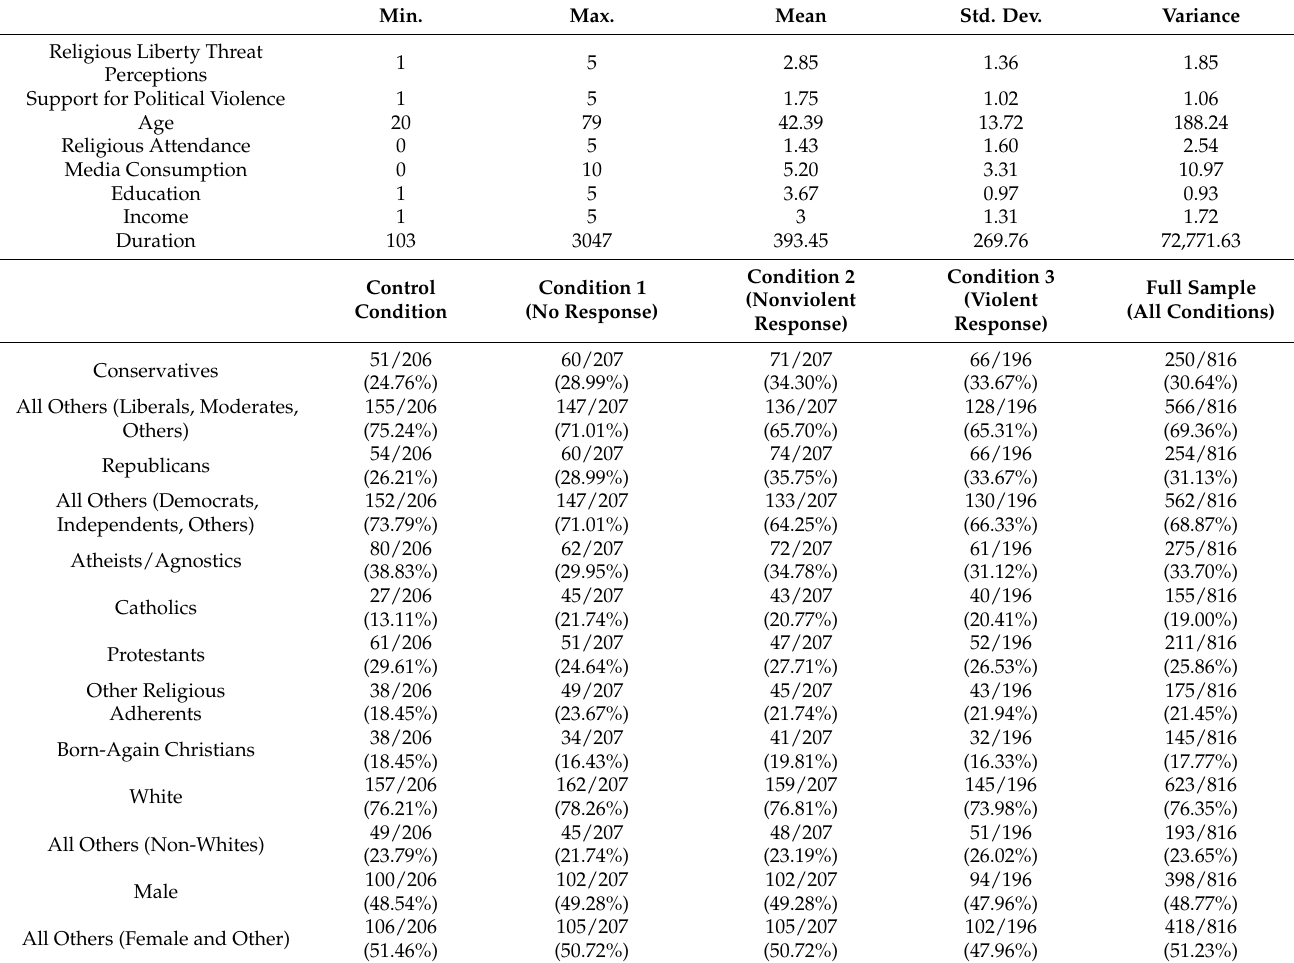
Table 3. Summary statistics and post-randomization demographic distributions.